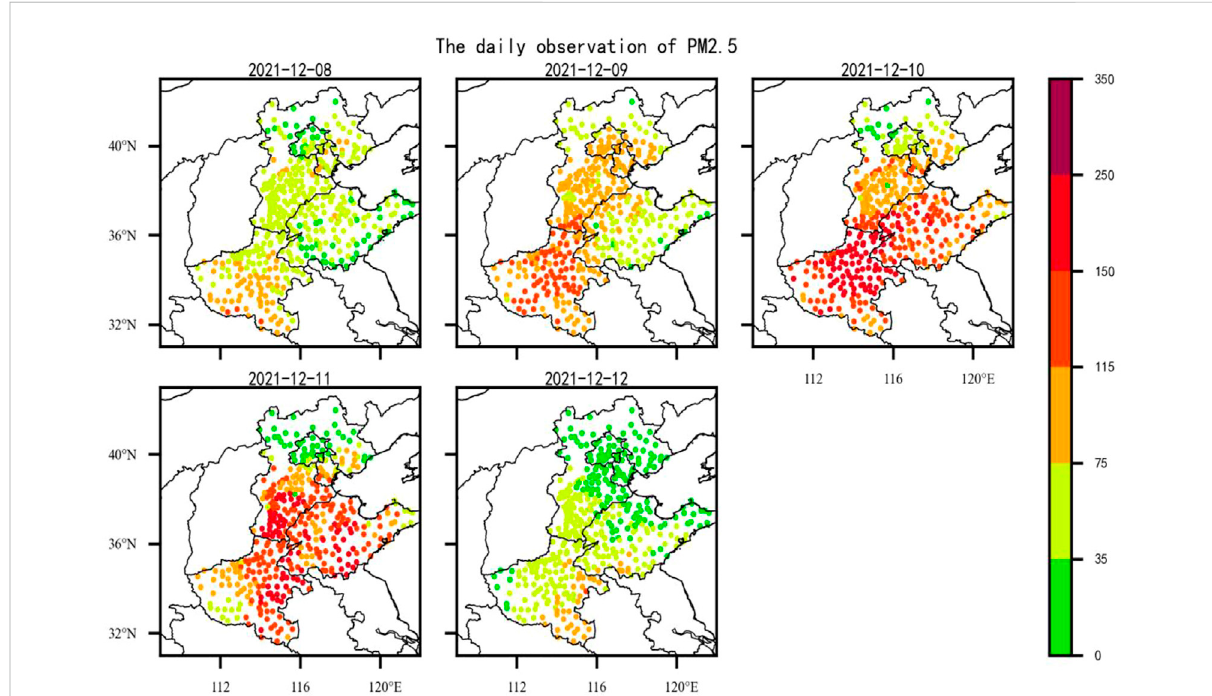
FIGURE 9 Distributions of daily PM 2.5 concentrations from December 8 to 12 of 2021 in BTH and its surrounding areas.